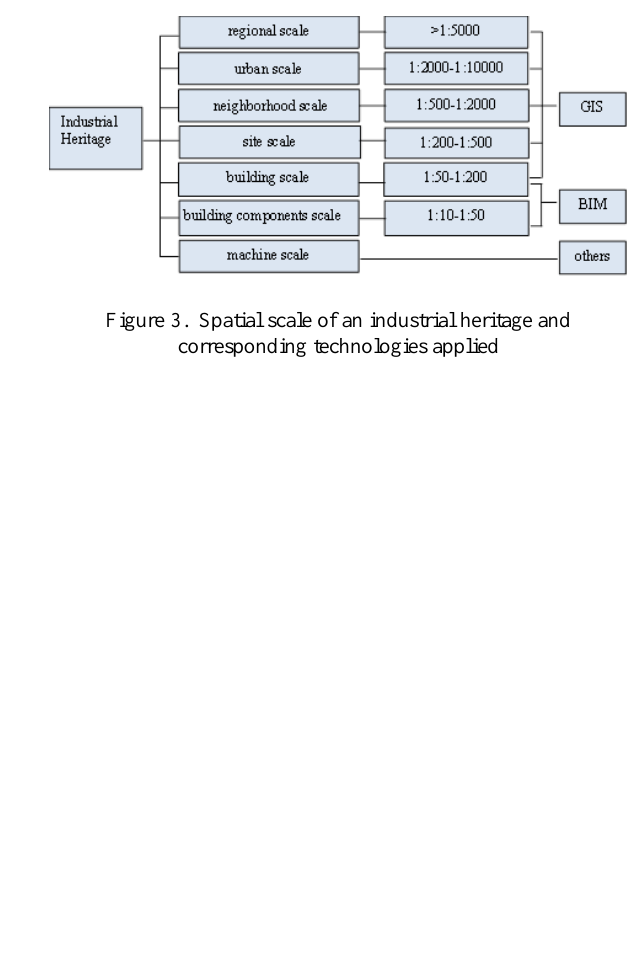
introduced to correspond to different levels of scale base on the research or practical questions, as well as data characteristics. Except the regional scale data (Figure 4), the CityGML database combine the level from the urban level and use 3D objects in lower levels of detail (LOD) in GIS system as basic unit. Higher LOD models are imported from BIM data. Organization of physical heritage properties and LOD levels can be found in more detail in section 4.1.